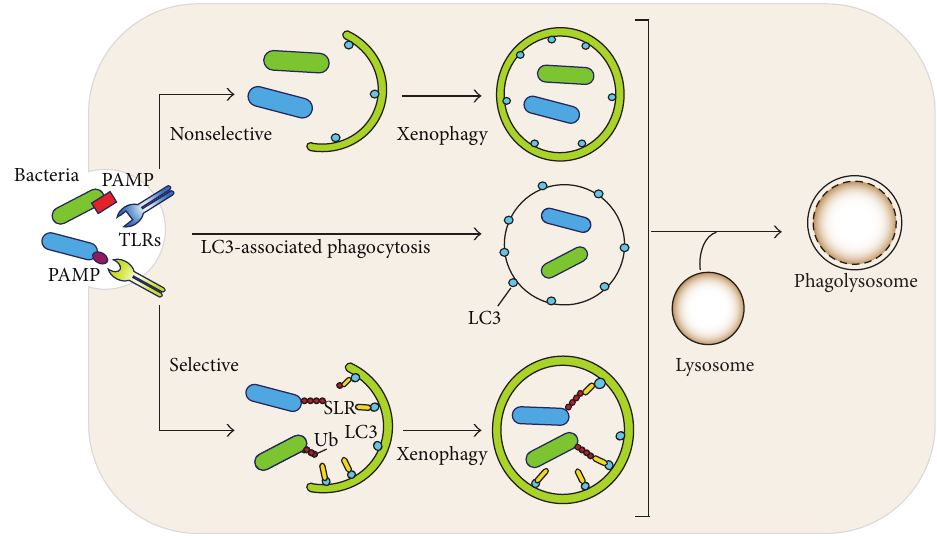
Figure 4: The autophagic response against intracellular pathogens (xenophagy) is shown. Xenophagy is initiated by the recognition of various PAMPs of different bacteria by corresponding TLRs. The invading microorganisms are phagocytized and delivered to autophagosomes. Xenophagy proceeds as either a nonselective or selective uptake of bacteria via signals, autophagic adaptors, and receptors. For the selective uptake, ubiquitinated bacteria are recruited into autophagosomes via sequestosome 1/p62-like receptors proteins. Another means of xenophagy is LC3-associated phagocytosis, which represents the recruitment of LC3 to phagosomes following TLR activation. LC3 recruitmenttosuchphagosomestriggersthefusionwithlysosomes.Allthreedifferentxenophagypathwayendswithlysosomalfusionleading to degradation of the engulfed